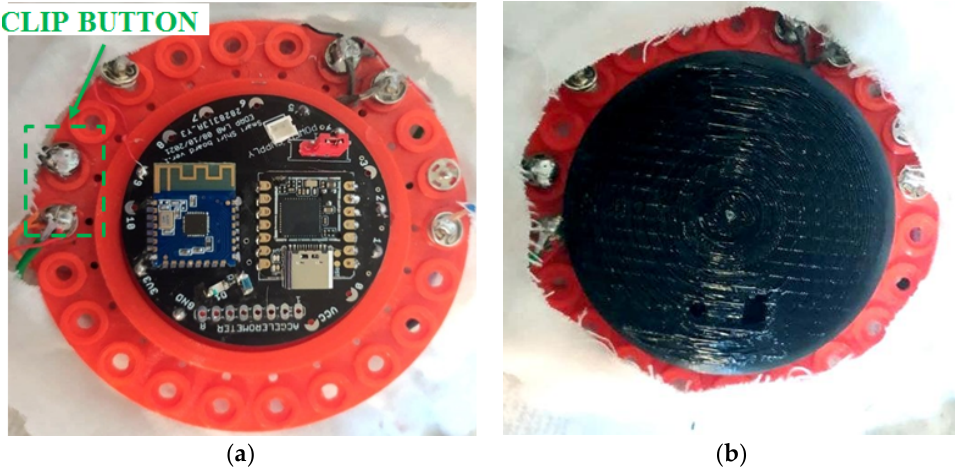
Figure 6. Details of the MCU board fixed on the garment by plastic support, with the connections terminated by clip button ( a ); plastic protective cover ( b